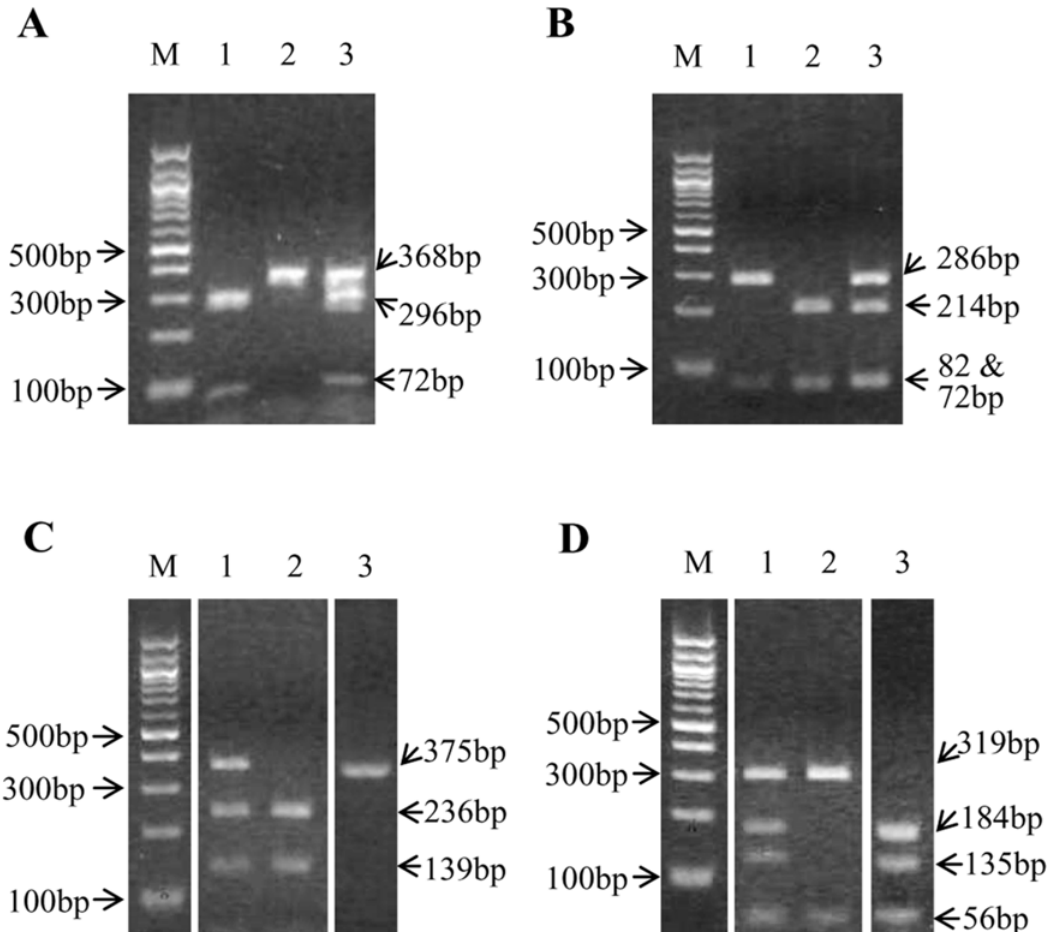
Fig 3. Restriction enzyme digests of PCR products amplified from genomic DNA coding for the DLD gene. M = size marker (100bp DNA Ladder, New England BioLabs Inc., MA USA); lanes 1, 2 and 3 on each gel are digests of individual beetles as noted. Gels A and B are digested products from homozygous resistant (RR), susceptible (SS) or heterozygous (RS) T . castaneum from the TcOK-G population digested with either MboI or BstNI, respectively. Gels C and D are similarly digested products from R . dominica . See text for details.